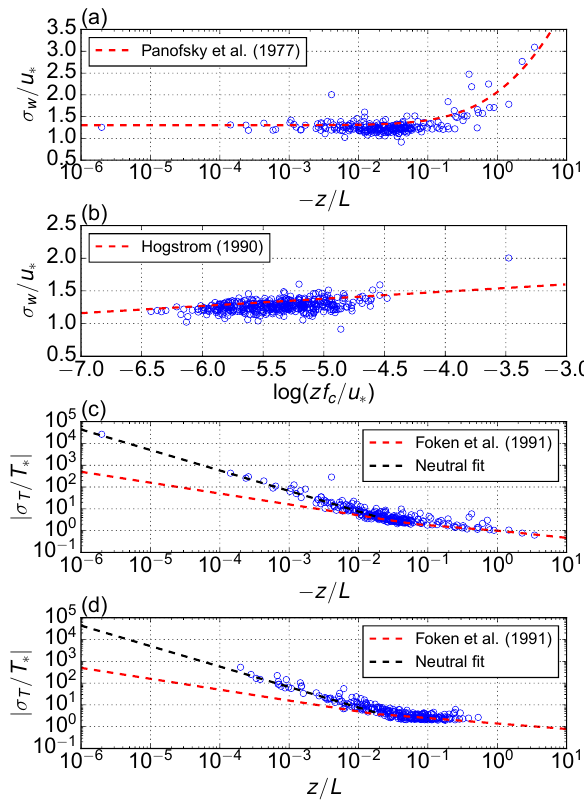
Figure C1. Integral turbulence characteristics. (a) σ w /u ∗ as a function of stability parameter z/L , (b) σ w /u ∗ as a function of zf c /u ∗ , (c) σ T /T ∗ as a function of z/L during unstable stability and (d) σ T /T ∗ as a function of z/L during stable